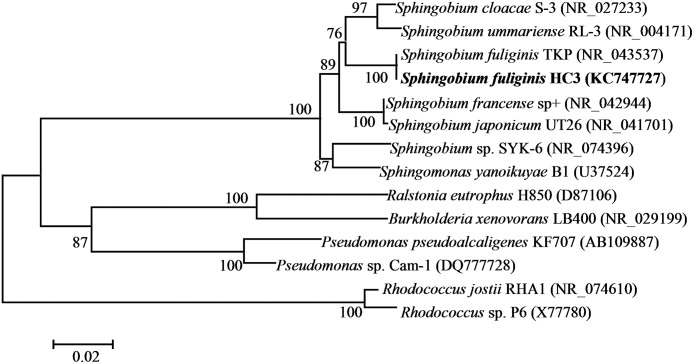
The neighbour-joining method cladogram showing a phylogenetic relationship between Sphingobium fuliginis HC3 and other related microorganisms in the genus Sphingobium and some deeply studied biphenyl/PCBs-degrading bacteria in other genera based on the 16S rDNA gene sequence analysis.Microorganisms’ names are followed by the accession numbers.